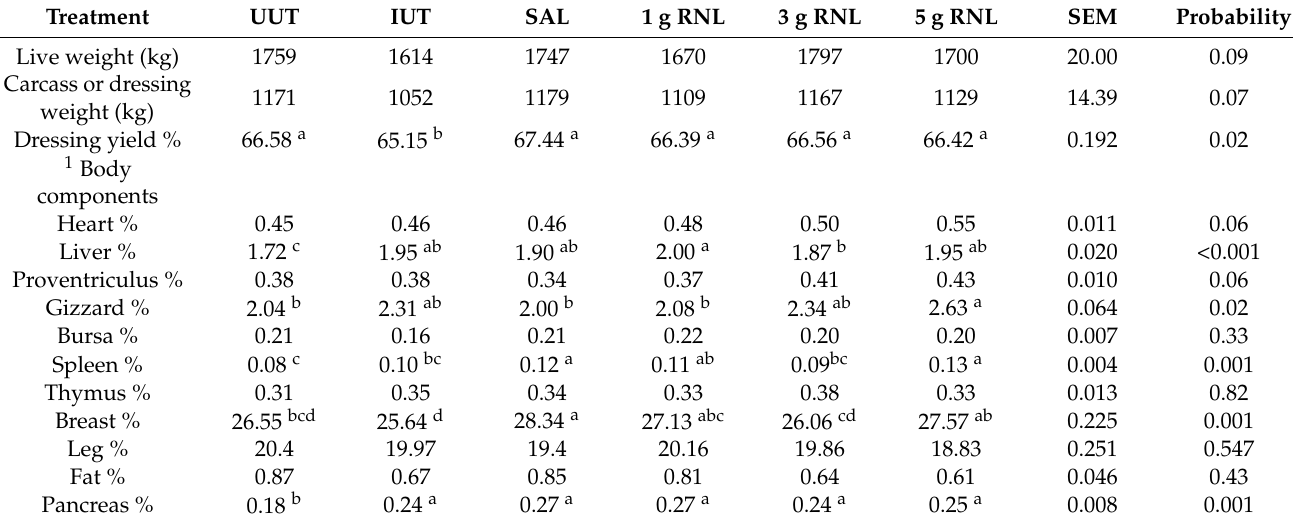
3.3. Muscle pH and Color